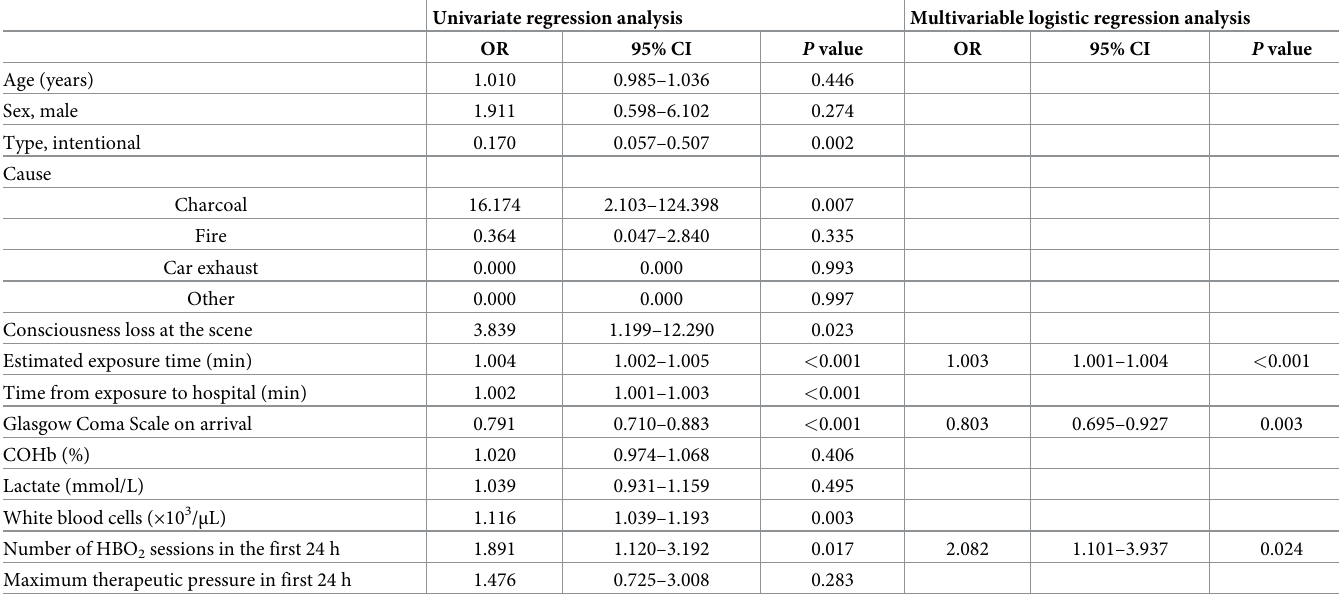
Table 5. Factors associated with the incidence of delayed neurological sequelae